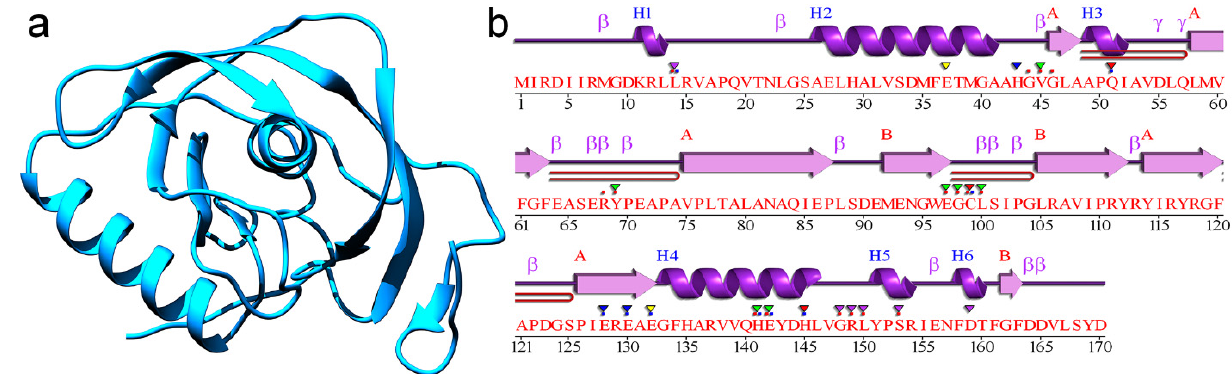
Figure 10. ( a ) 3D molecular structure of peptide deformylase; ( b ) secondary structure of peptide deformylase.